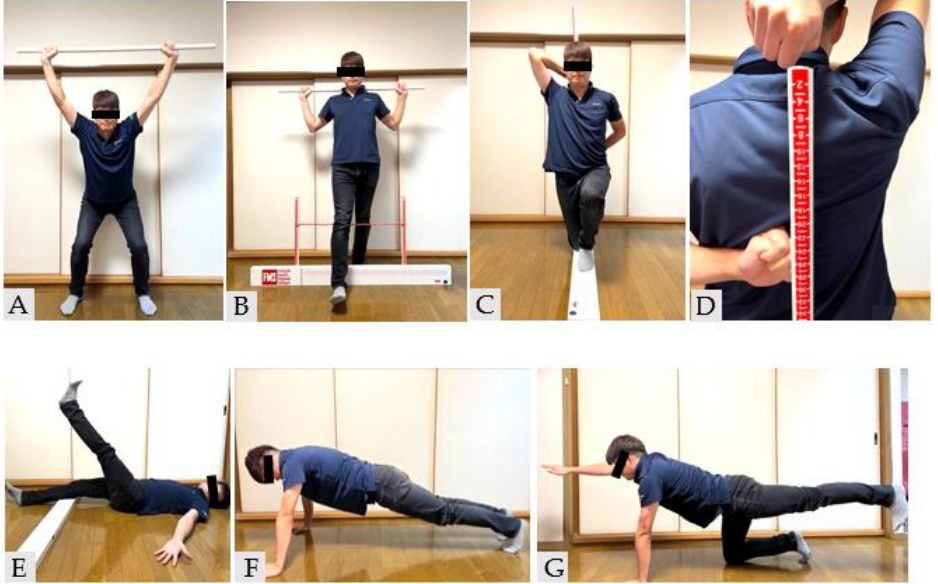
Figure 1. Functional movement screen. ( A ) Deep squat, ( B ) hurdle step, ( C ) inline lunge, ( D ) shoulder mobility, ( E ) active straight leg raise, ( F ) trunk stability push-up, and ( G ) rotary stability. Measurements were taken before the intervention, 12 weeks after the intervention, and after 12 weeks of follow-up. One FMS-trained physical therapist measured all items to reduce measurement bias and was